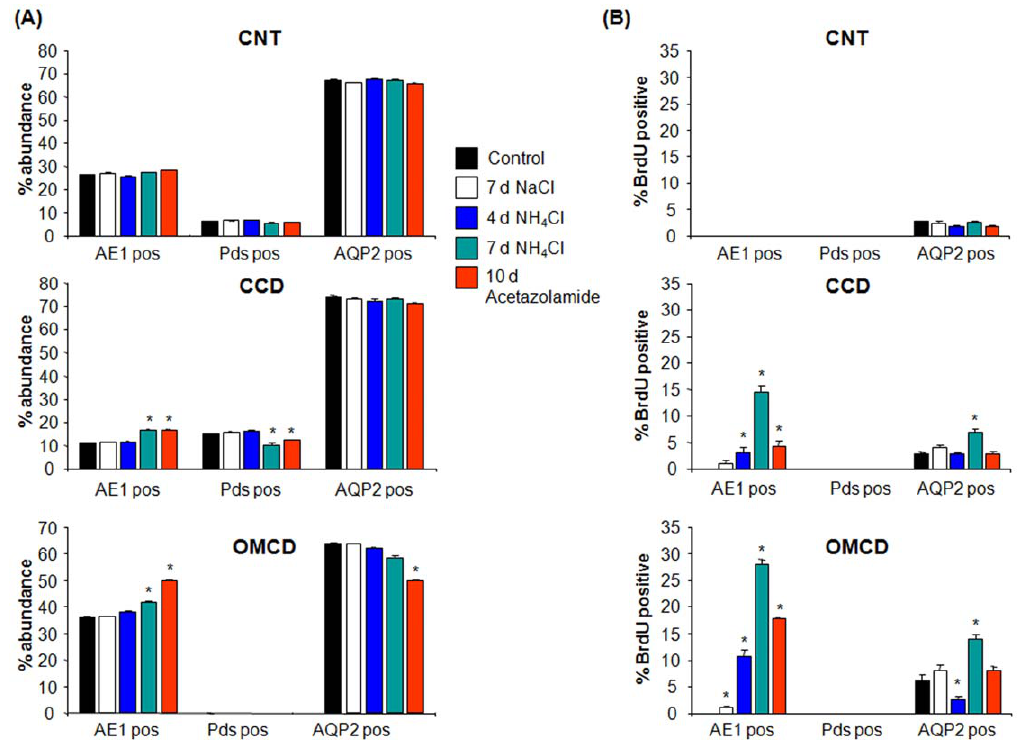
Figure 8. Remodelling and BrdU positive cell counts. ( A ) Summary of cells counts assessing the relative abundance of AE1, pendrin or AQP2 positive cells in the CNT, CCD, and OMCD of rats treated for 4 or 7 days with NH 4 Cl, 7 days with NaCl, or 10 days of acetazolamide in the drinking water. ( B ) Percentage of AE1, pendrin, or AQP2 positive cells that were stained for BrdU and the respective cell marker under the different conditions. * marks significant difference compared to control. doi:10.1371/journal.pone.0025240.g008 Table 4. BrdU labeled cells.